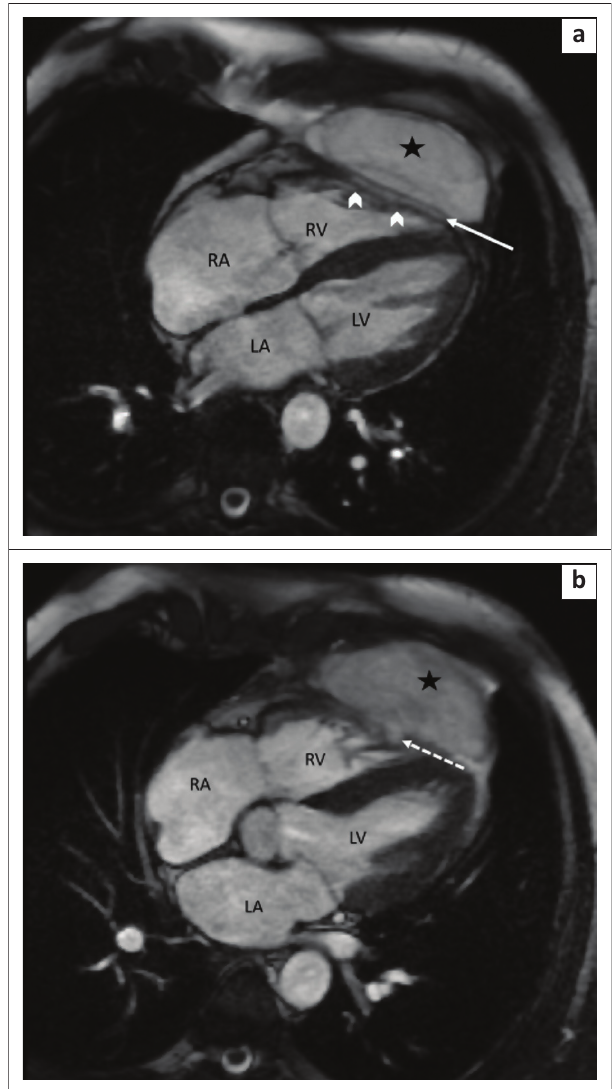
RA, right atrium; RV, right ventricle; LA, left atrium; LV, left ventricle. FIGURE 9: A 33-year-old man with liposarcoma of the pericardium. The cine SSFP axial image (a) demonstrates a large hyper-intense mass adjacent to the right ventricle ( * ) with clear separation (white arrow) between the mass and the right ventricular myocardium (white arrow heads) during systole when the ventricle moves away from the lesion. The cine SSFP axial image (b) demonstrates a small area of local invasion of the right ventricular myocardium (white dashed arrow) at the mid-ventricular level with extension of the tumour into the right ventricle.